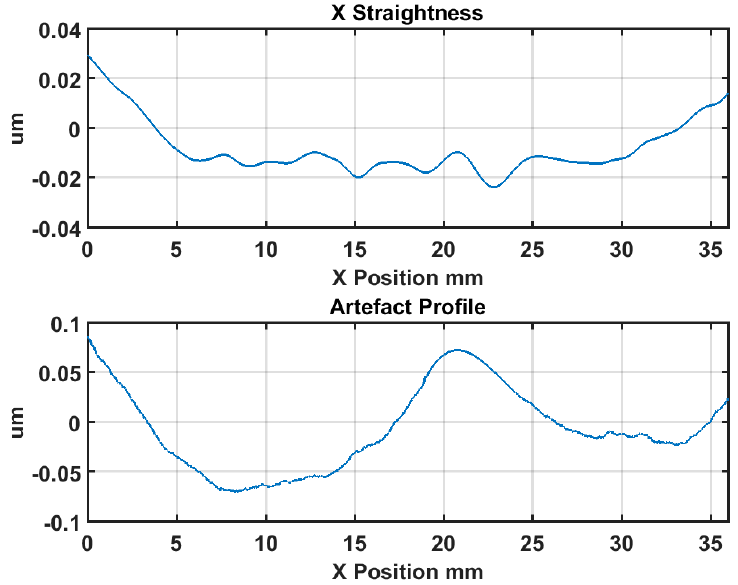
Figure 8. Error separation results of straightness error E ZX and artefact profile error E flat.